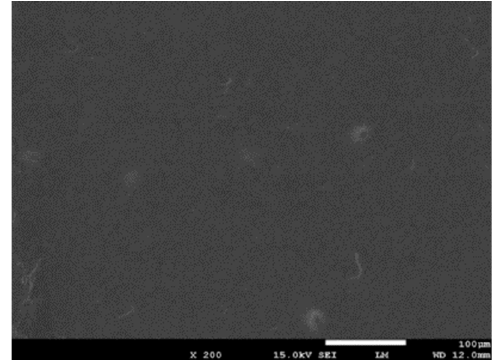
Figure 4: Image of matrix asphalt.